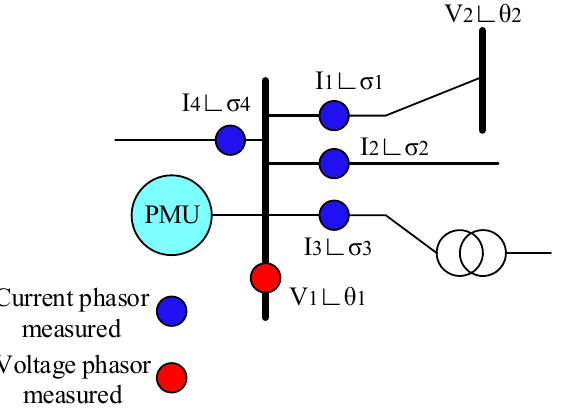
Figure 2. PMU connected to a bus.